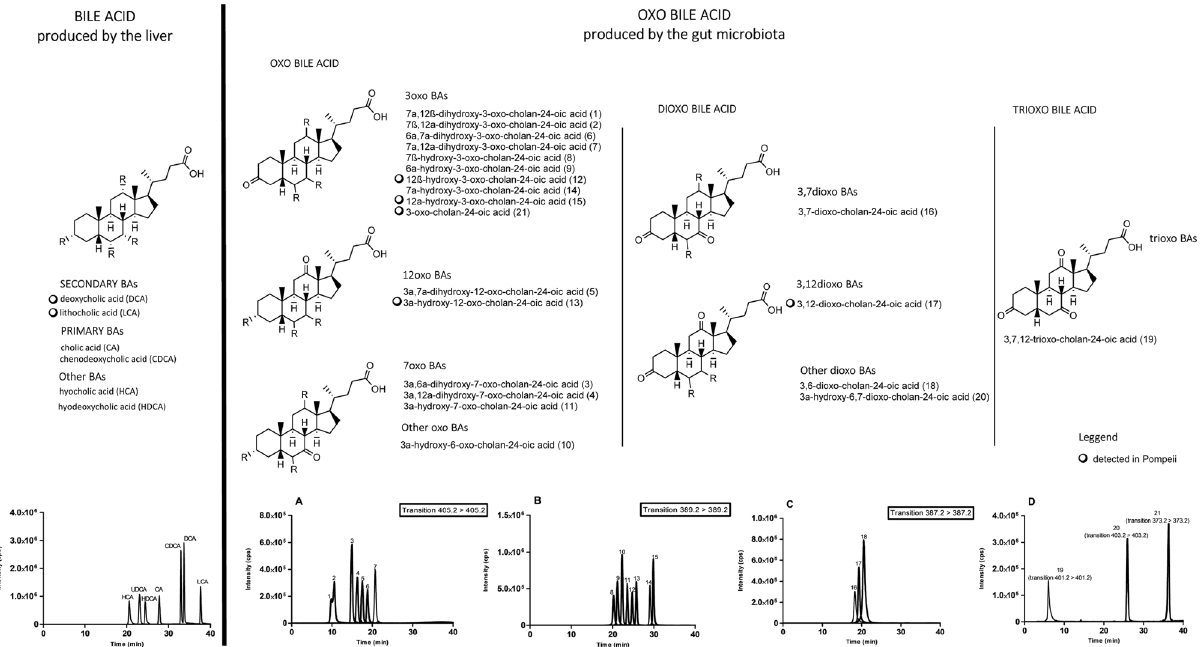
reported subdivided into mono, di e try